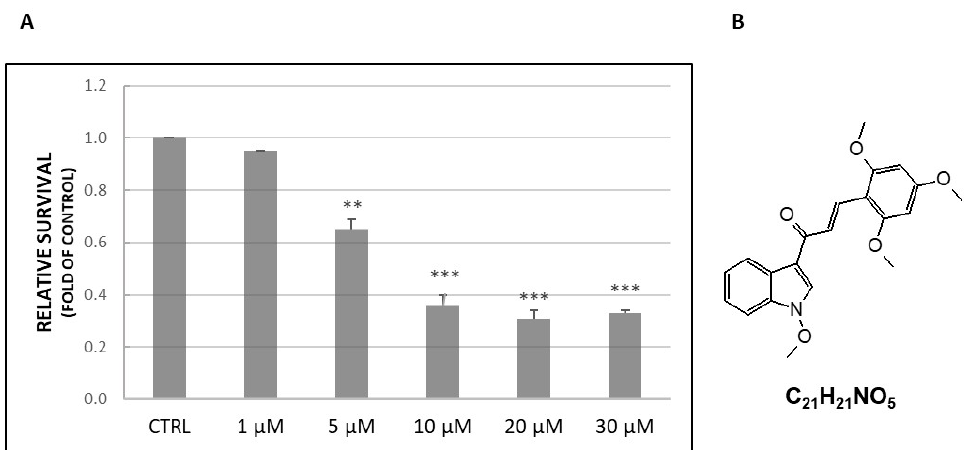
Figure 1. MTS assay ( A ) performed on HeLa cells treated with chalcone L1 ( B ). Representative data of three independent experiments are presented. Significantly different ** p < 0.01, *** p < 0.001 vs. untreated cells (control).